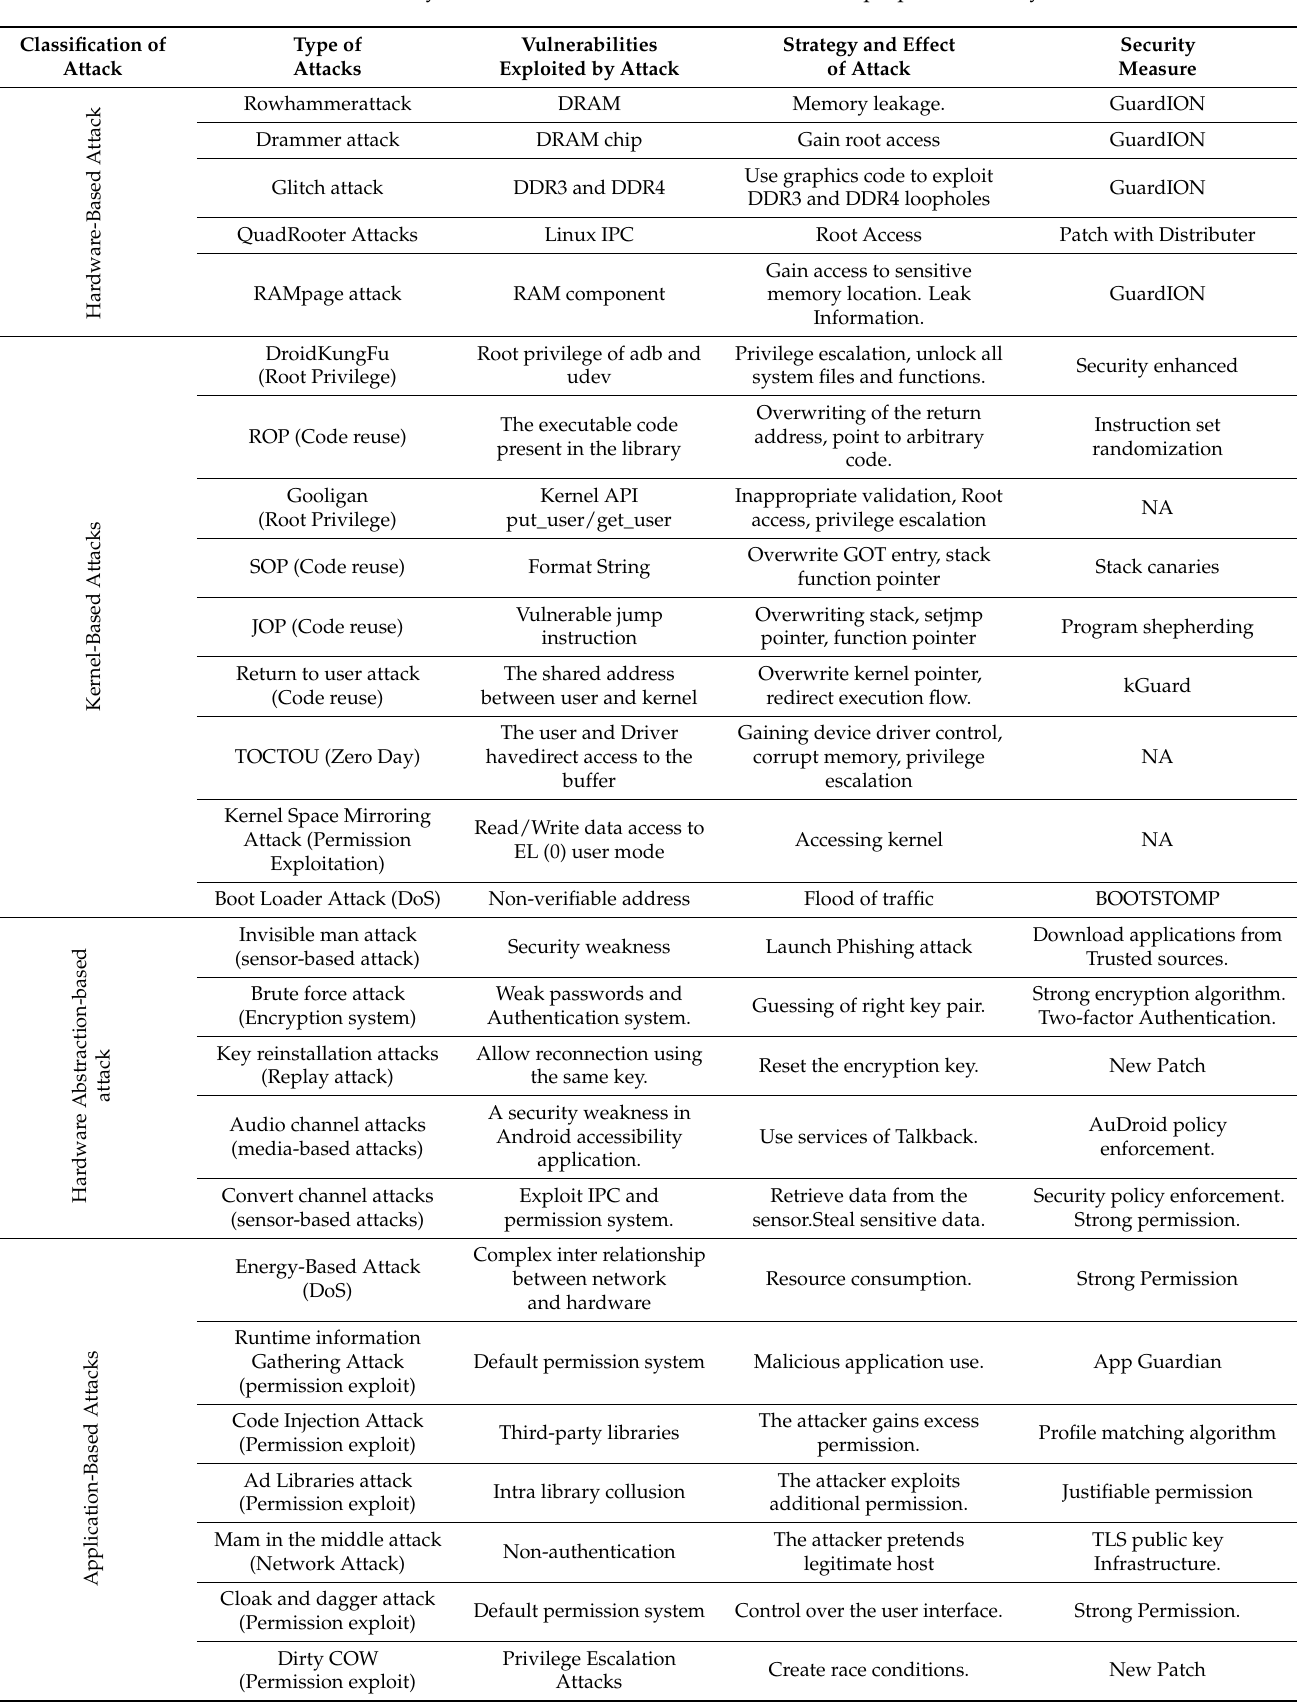
Table 2. Layered attacks on Android Architecture with proposed security